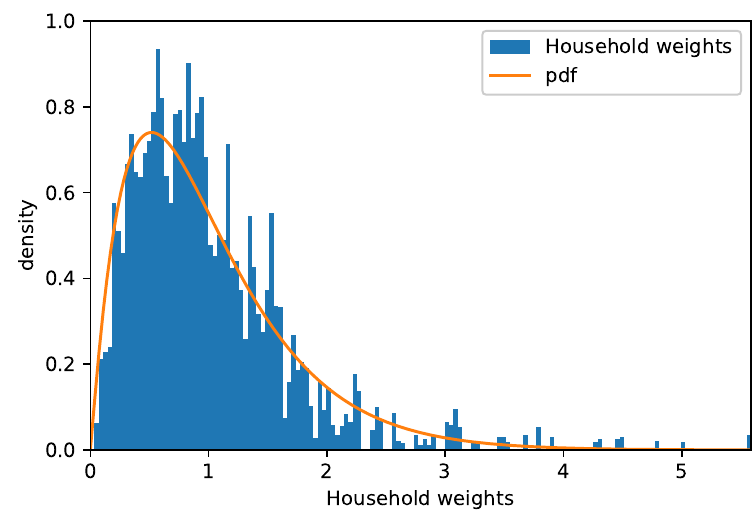
Figure 2. Distribution of normalized household weights.